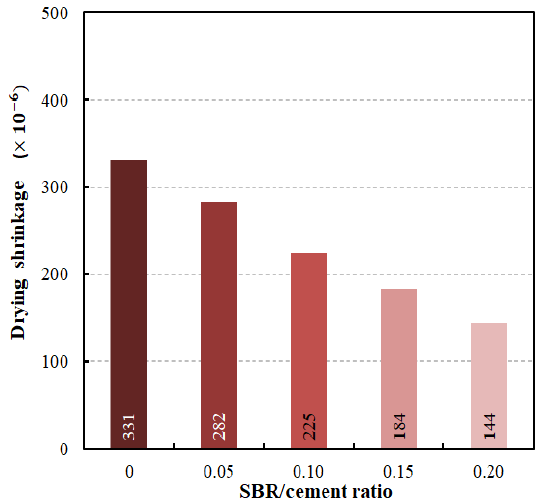
ff erent SBR / cement